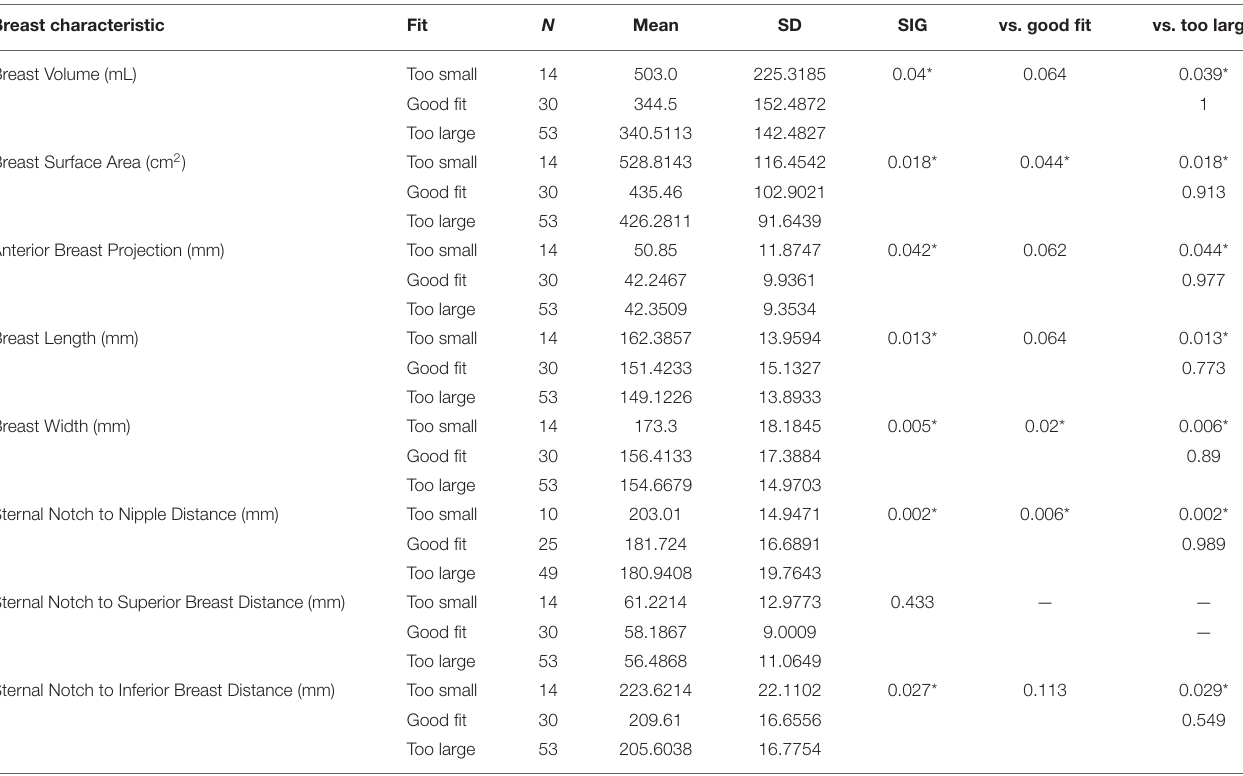
TABLE 6 | Breast characteristic data compared between the three fit groups (too small, good fit, and too large) using One-Way ANOVA (normally distributed data; difference in group means) or Kruskal–Wallis (non-normally distributed data; difference in mean rank). Breast